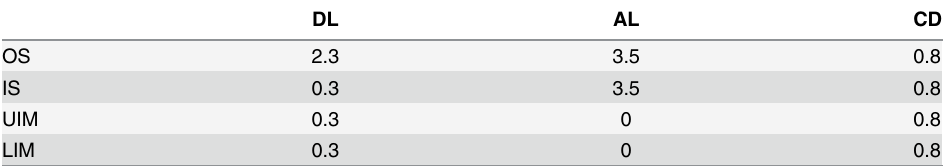
Table 5. Rates of total ammonia production in the various tubular segments (pmol.min -1 .mm -1 tube) [15]. DL